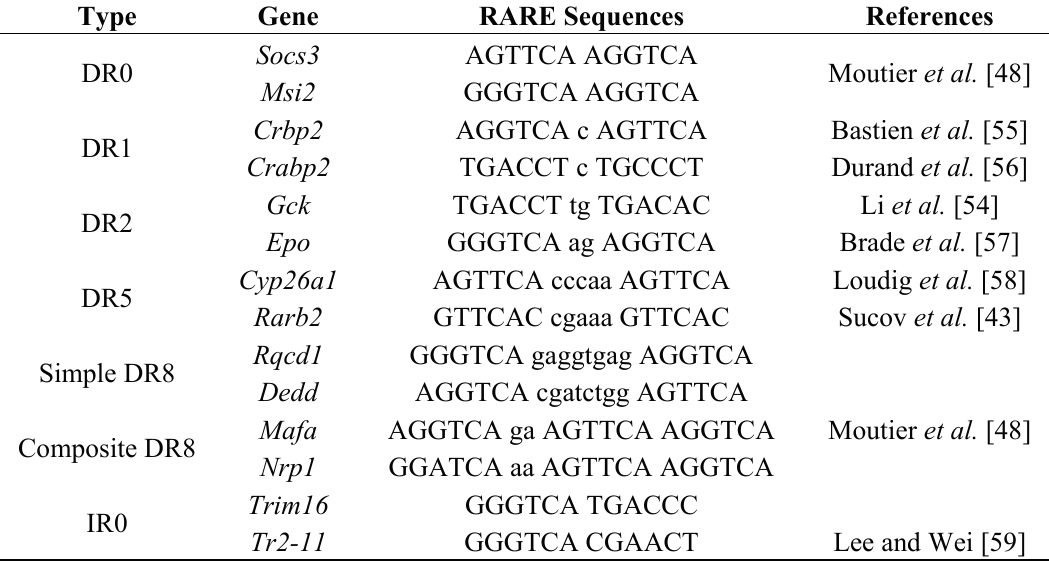
Table 1. Representative genes bearing retinoic acid response element (RARE) consensus motifs. All RARE sequences are from mouse genome except Gck , which is from rat. Socs3 , the suppressor of cytokine signaling 3; Msi2 , musashi RNA-binding protein 2; Crbp2 , cellular retinol binding protein II; Crabp2 , cellular retinoic acid binding protein II; Gck , glucokinase; Epo , erythropoietin; Cyp26a1 , cytochrome P450 26A1; Rarb2 , retinoic acid receptor β 2; Rqcd1 , RCD1 required for cell differentiation 1 homolog; Dedd , death effector domain containing; Mafa , v-maf musculoaponeurotic fibrosarcoma oncogene family, protein A; Nrp1 , neuropilin 1; Tr2-11 , testicular receptor 2-11; Trim16 , tripartite motif-containing protein 16. Nucleotides separating the two motifs are shown in lower-case